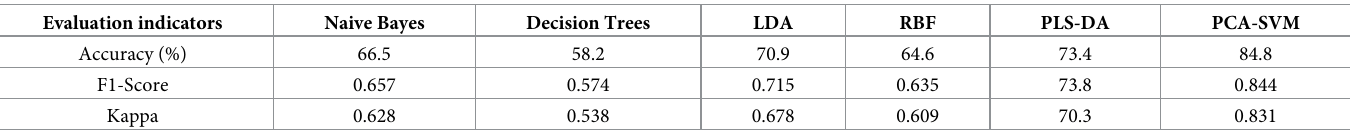
Table 3. Comparison results of models for origin identification of Cornus officinalis based on mid-infrared spectroscopy. Evaluation